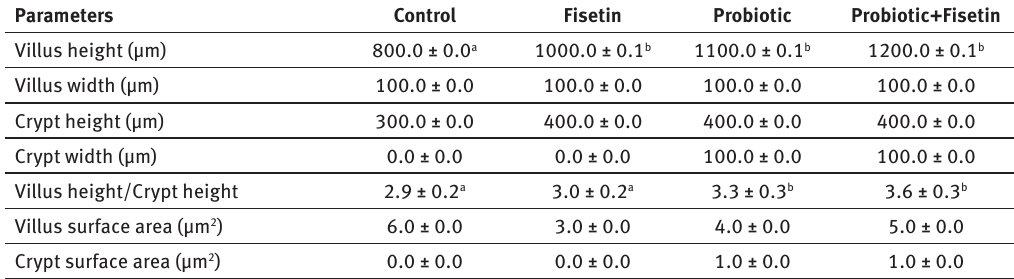
Table 7. Effect of probiotic and/or fisetin on small intestinal morphometric parameters in broiler chickens Parameters